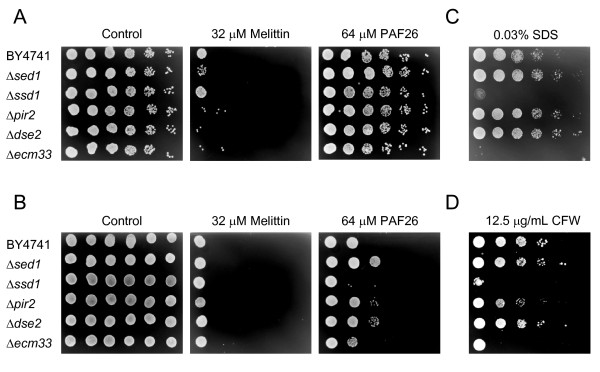
Analysis of sensitivity to peptides and to CW disturbing compounds of S. cerevisiae deletion mutants in CW-related genes. Data on sensitivity of the single gene deletion strains Δsed1, Δssd1, Δpir2, Δdse2, Δecm33, and the corresponding parental strain BY4741 are shown. (A) and (B) show results after treatment of serial 5-fold dilutions of exponentially growing cells with each peptide for 2 hours (Panel A) or 24 hours (Panel B) and subsequent plating onto YPD peptide-free plates. (C) and (D) show growth of serial dilutions of the same deletion strains on YPD plates containing SDS (Panel C) or CFW (Panel D).